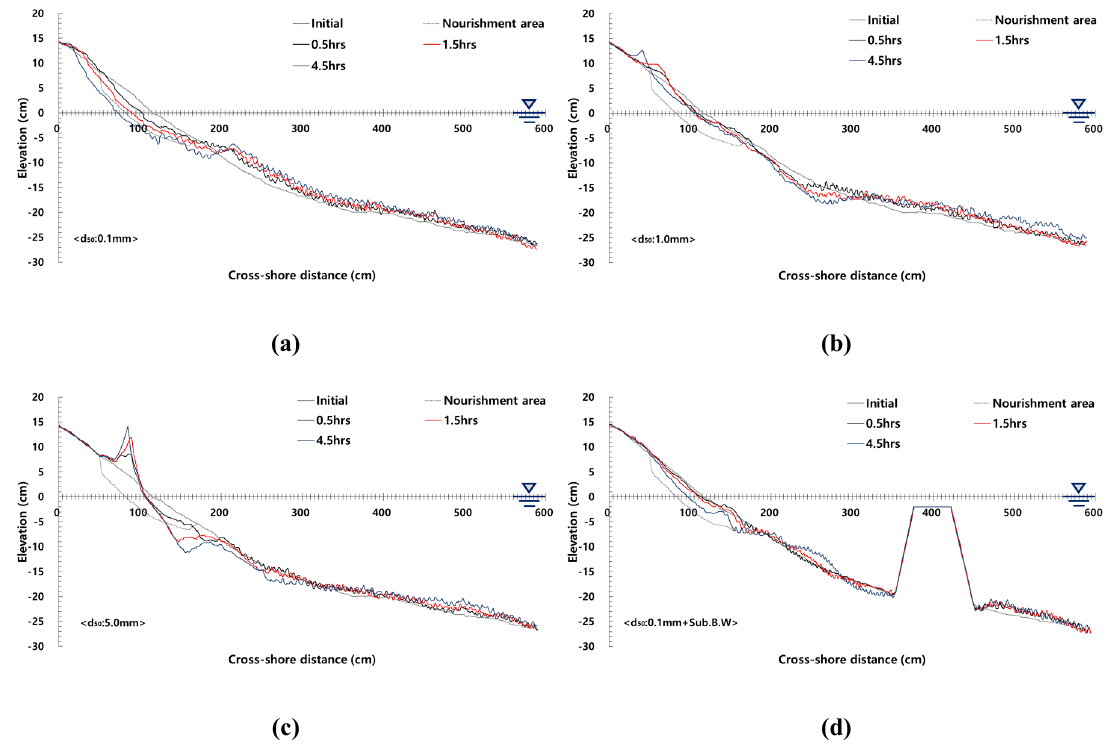
Figure 5. Beach profile evolution with wind velocity; U: 8 m/s : ( a ) d 50 , 0.1mm, ( b ) d 50 , 1 mm, ( c ) d 50 , 5mm, ( d ) d 50 , 0.1mm + Sub. B.W.